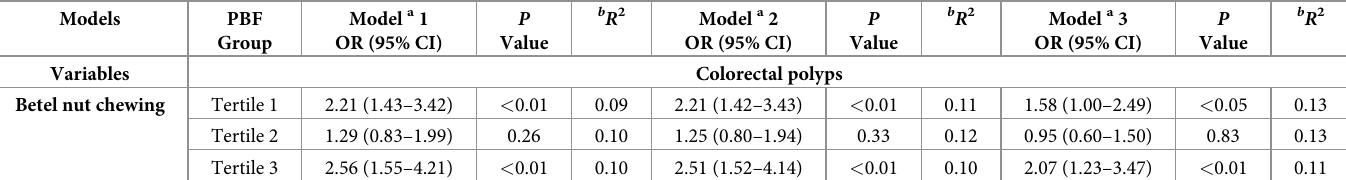
Table 4. Association between betel nut chewing and the presence of colorectal polyps categorized by the tertiles of PBF. Models